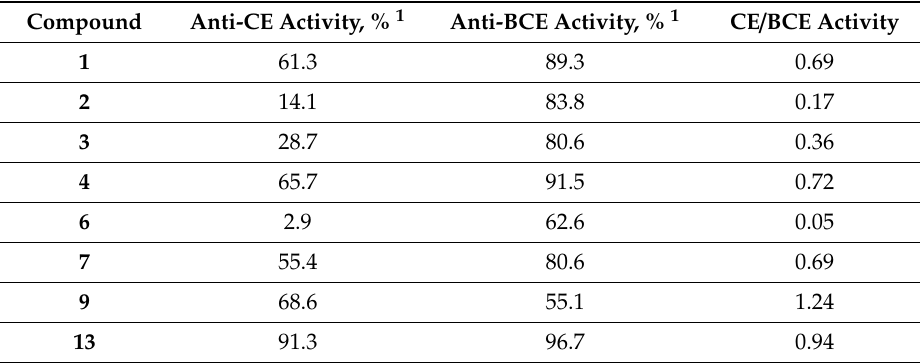
Table 4. Esterase inhibition activity of compounds 1 – 7 , 9 , and 13 .